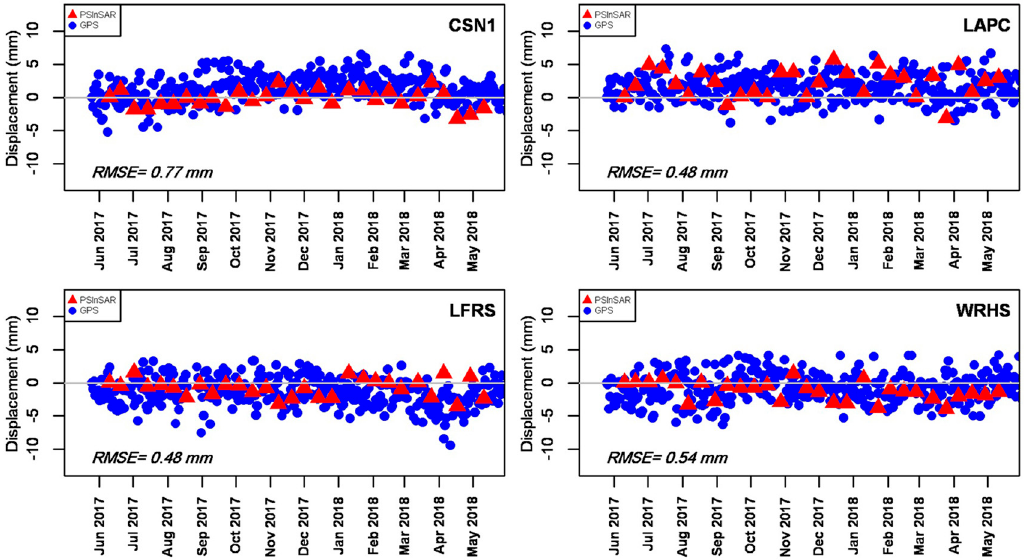
Figure 8. Comparison between PSInSAR-derived time series deformation (red triangles) and GPS observations (blue dots), Line-of-Sight direction, from June 2017 to May 2018.